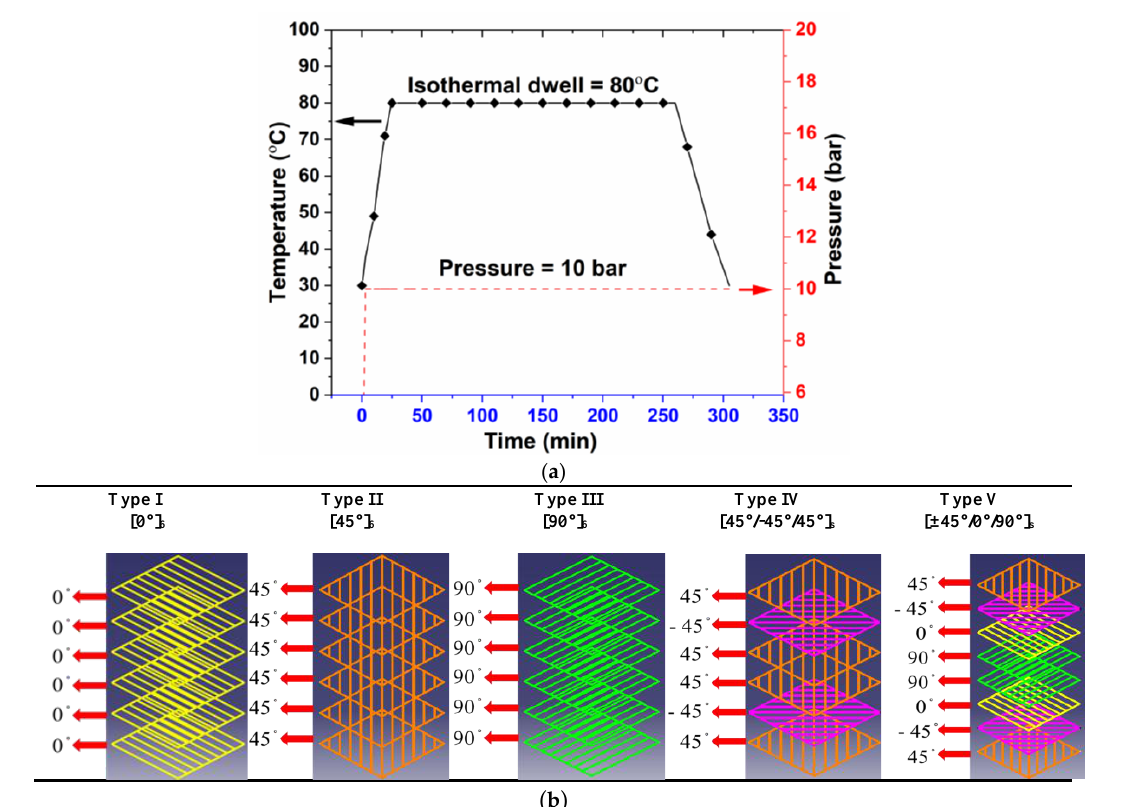
Figure 1. ( a ) Cure cycle used in this study to fabricate the laminates. ( b ) Schematic representation of different fiber orientations of